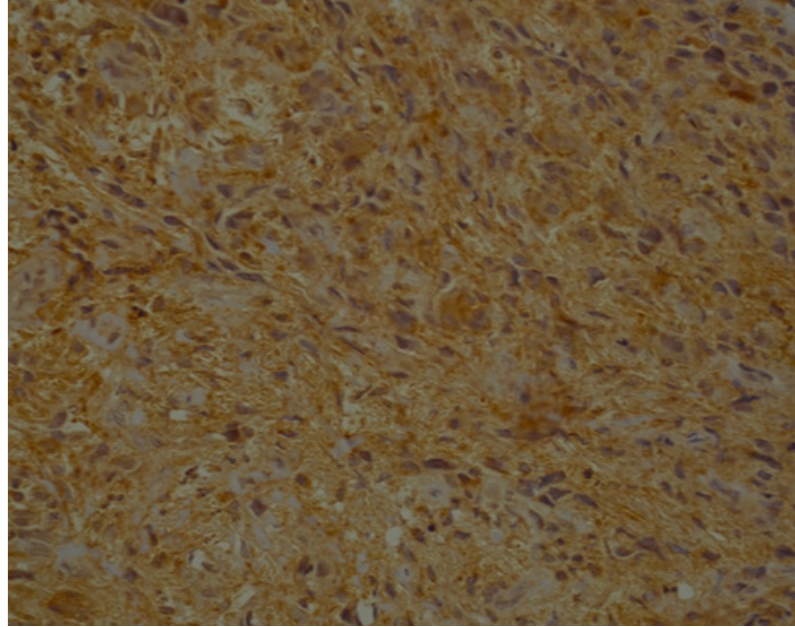
Figure 7. TNF- α —moderate brown staining in stroma of OSCC (40x). J. Clin. Med. 2020 , 9 , x FOR PEER REVIEW